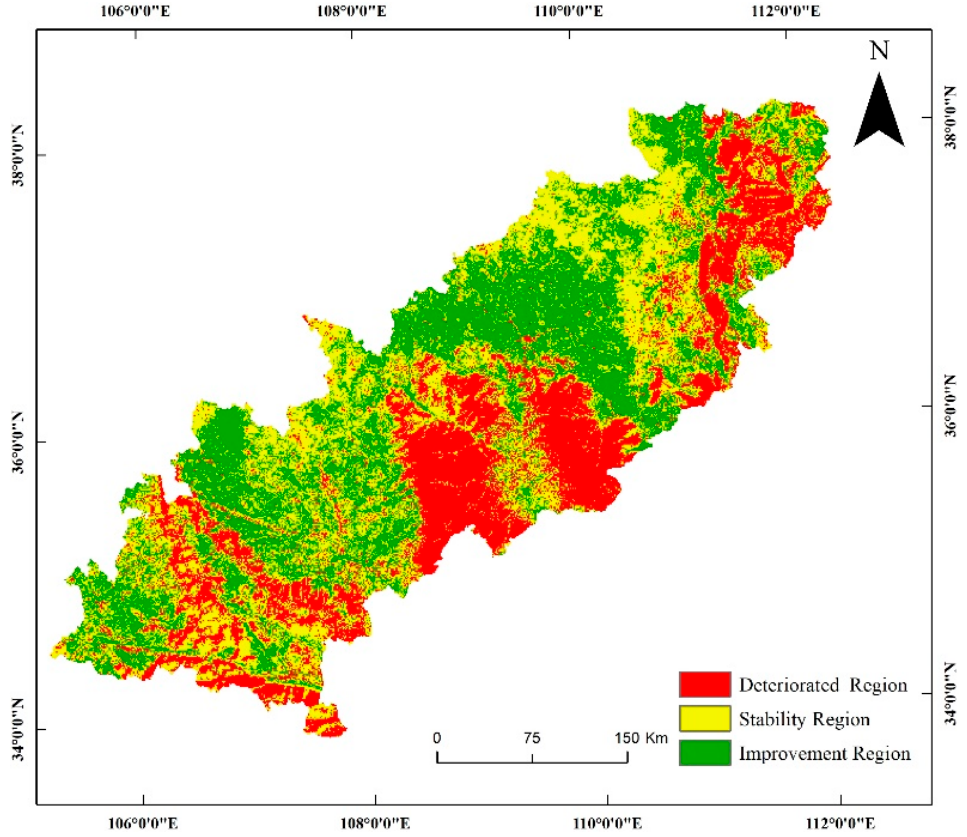
Figure 10. Distribution of changes in NPP in the Loess Plateau Ecological Screen from 2005 to 2015.